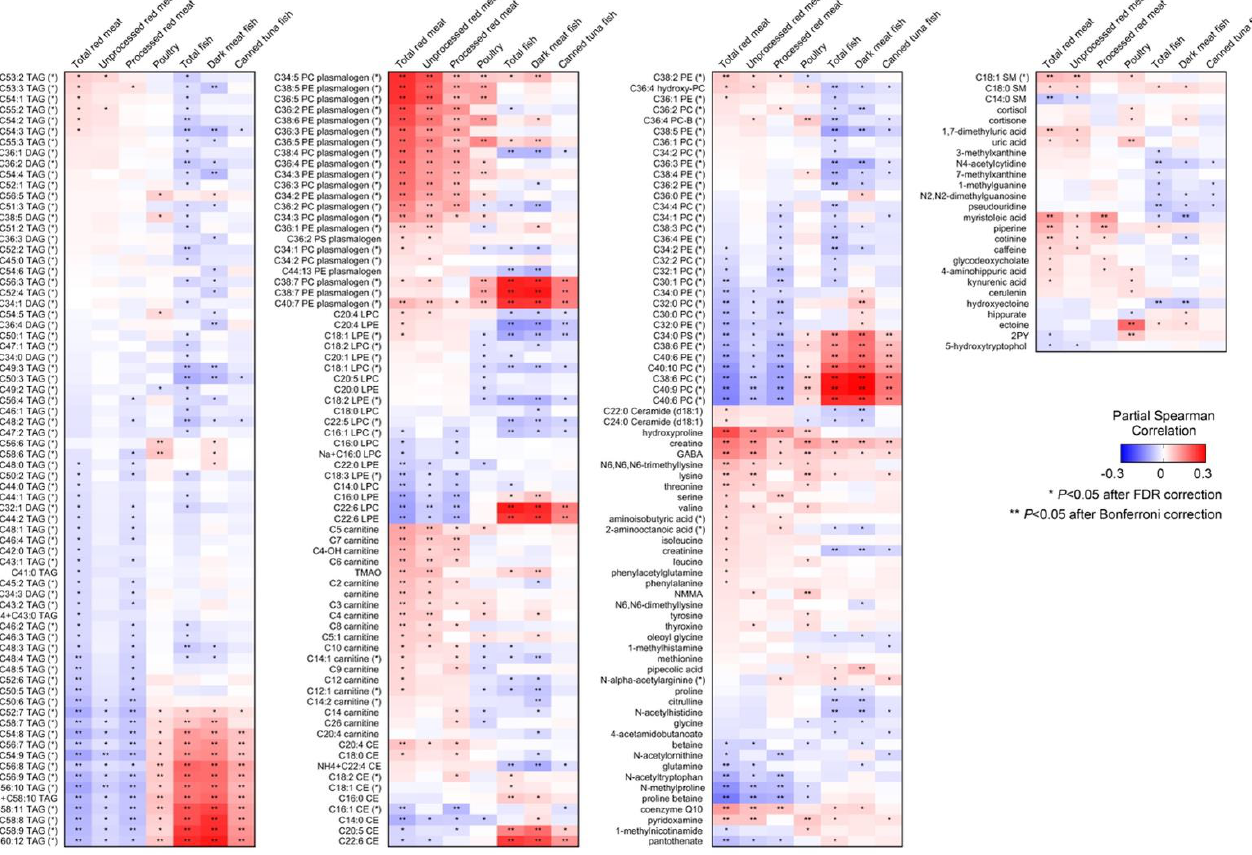
Figure 2. Heatmap of known metabolites that are significantly associated with meat and fish intake. Only metabolites significantly (after FDR correction) correlated with at least one meat or fish group are shown. The intensity of the colors represents the degree of association between plasma metabolites and consumption of total red meat, unprocessed red meat, processed red meat, poultry, total fish, dark meat fish, and canned tuna fish, as measured by partial Spearman correlation analyses adjusting for age at blood draw, fasting status, endpoints, and case/control status in the original sub-study, BMI, smoking, physical activity, alcohol intake, total energy intake, and modified AHEI. These meat and fish groups were also mutually adjusted. Metabolite with “(*)” indicate a representative name. *, p < 0.05 after FDR correction and **, p < 0.05 after Bonferroni correction. AHEI, Alternate Healthy Eating Index; BMI, body mass